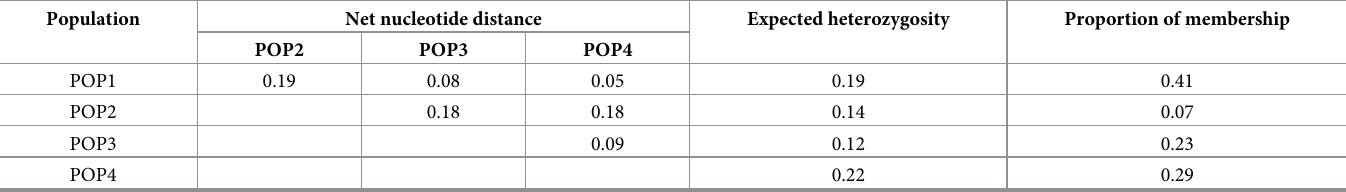
Table 2. Genetic divergence among (net nucleotide distance) and within (expected heterozygosity) populations, and the proportion of membership of the popula- tion samples. Population